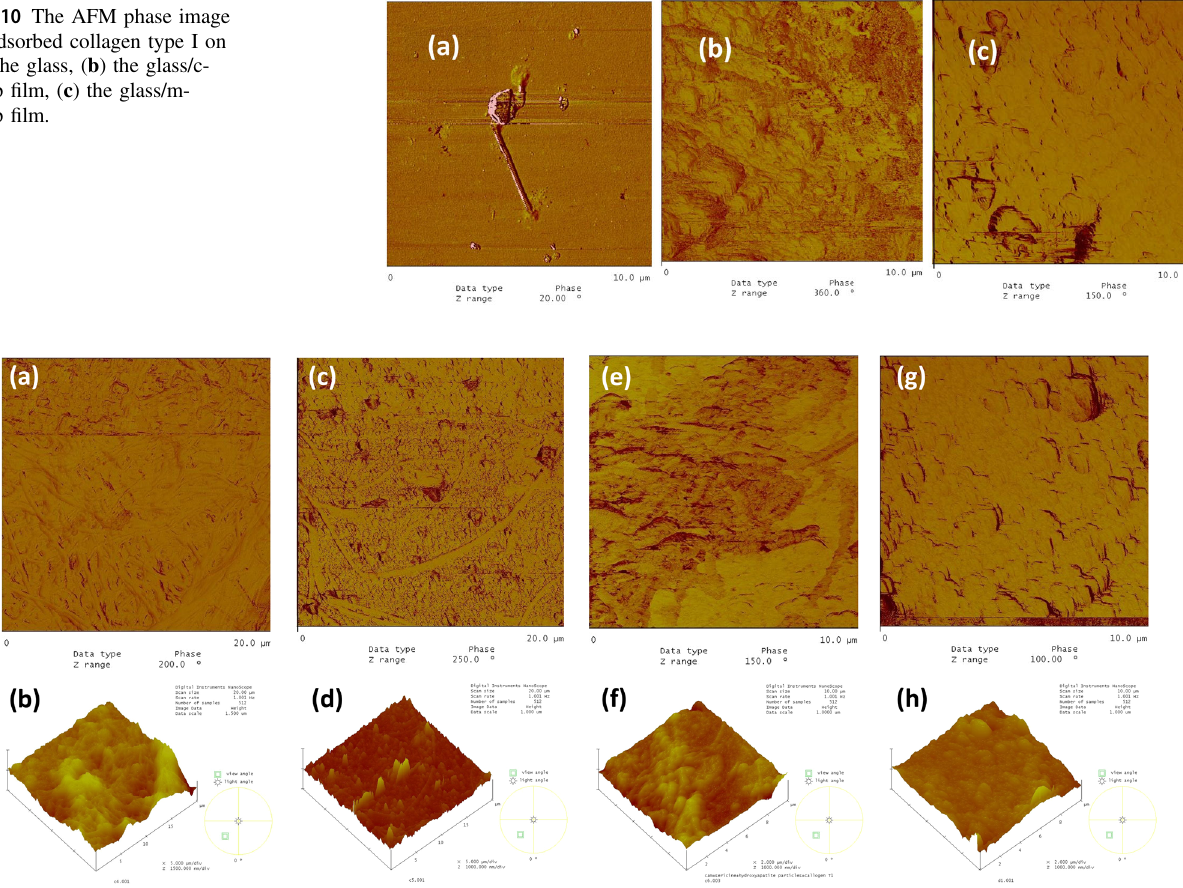
Fig. 11 The AFM images of adsorbed collagen type I on ( a ). a the glass/ fi broin/c-HAp; phase image, ( b ) the glass/ fi broin/c-HAp; 3-dim. topographical image, ( c ) the glass/ fi broin/m-HAp; phase image, ( d ) the glass/ fi broin/m-HAp; 3-dim. topographical image, ( e ) the glass/sericin/